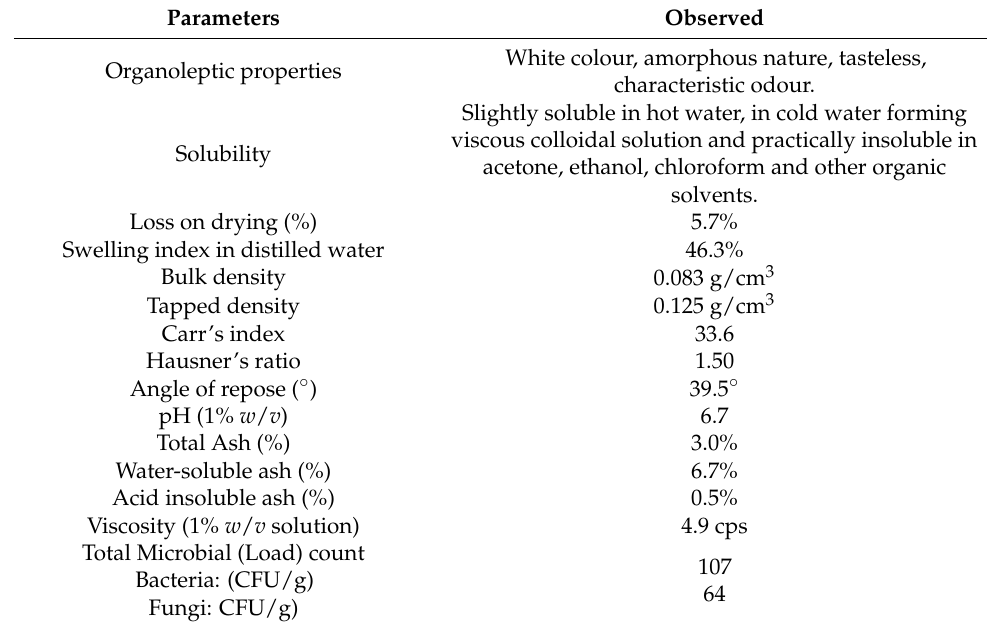
Table 4. Results of Physicochemical characterization of Coccinia grandis